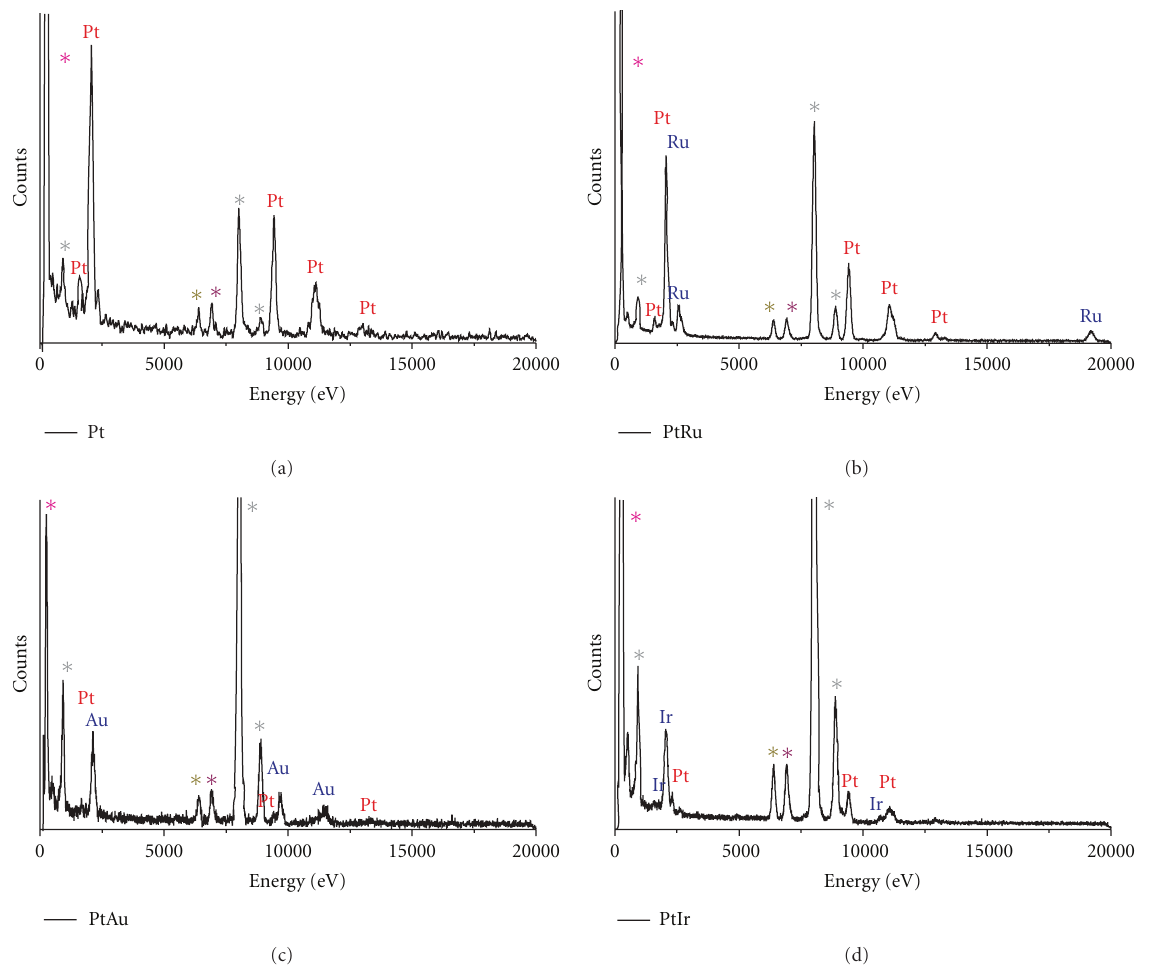
Figure 2: EDX spectra of pure Pt (a) and bimetallic PtRu (b), PtAu (c) and PtIr (d) nanoparticle. (TEM instrument, carbon, and copper grid spectra corresponding to olive green asterisk: Fe, violet asterisk: Co, pink asterisk: C, and gray asterisk: Cu).